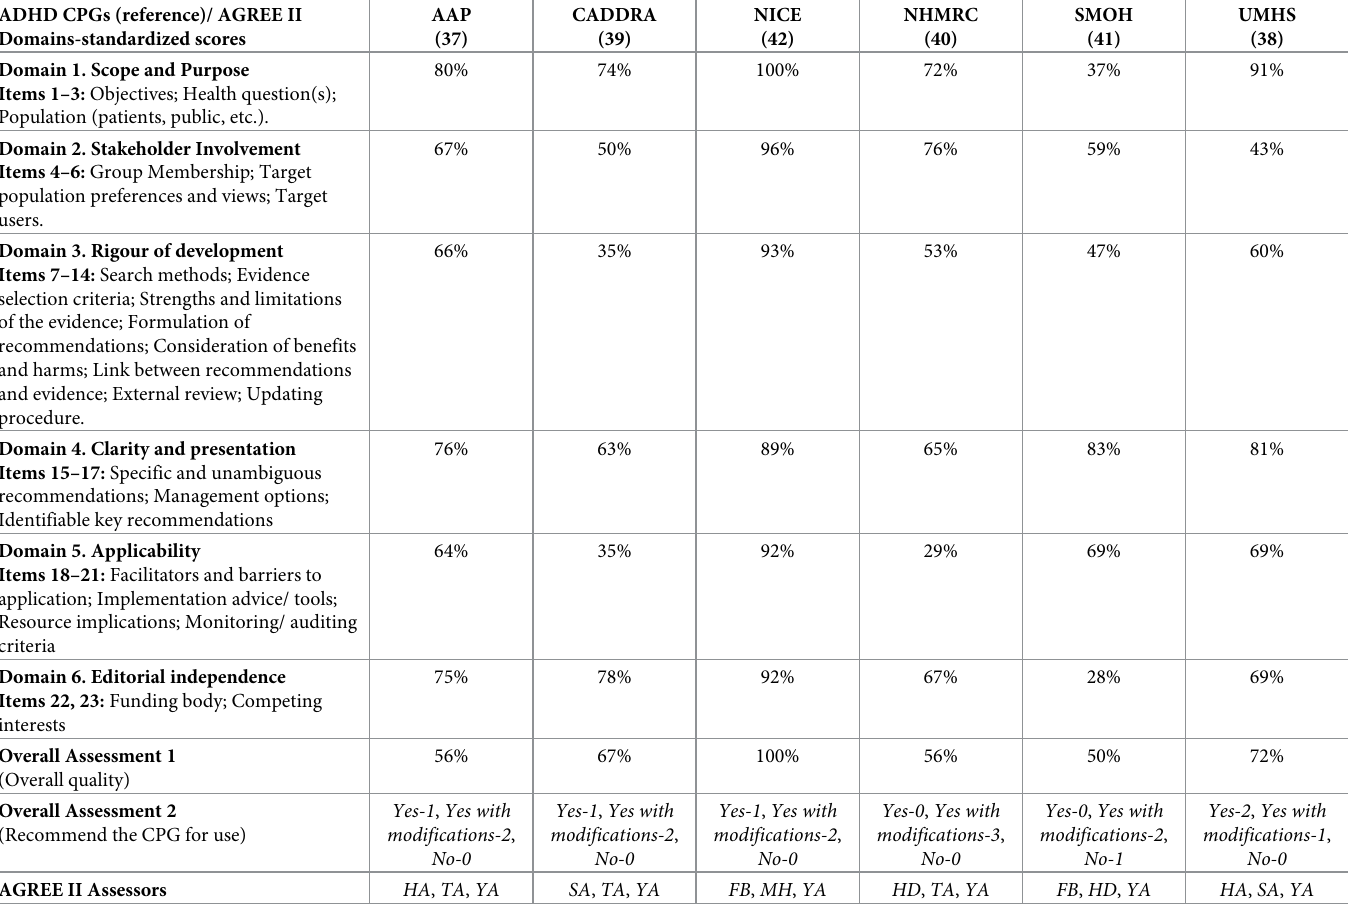
Table 3. AGREE II domain-standardized scores (ratings) for CPGs on management of